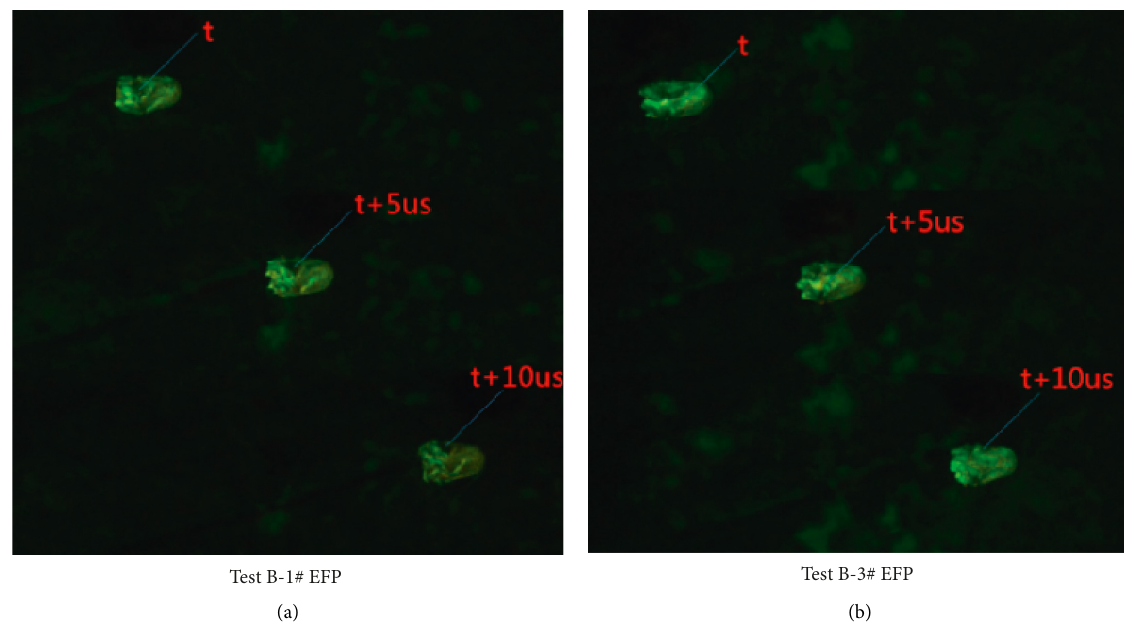
Figure 8: EFP flight patterns for tests. (a) B-1# and (b) B-3#.